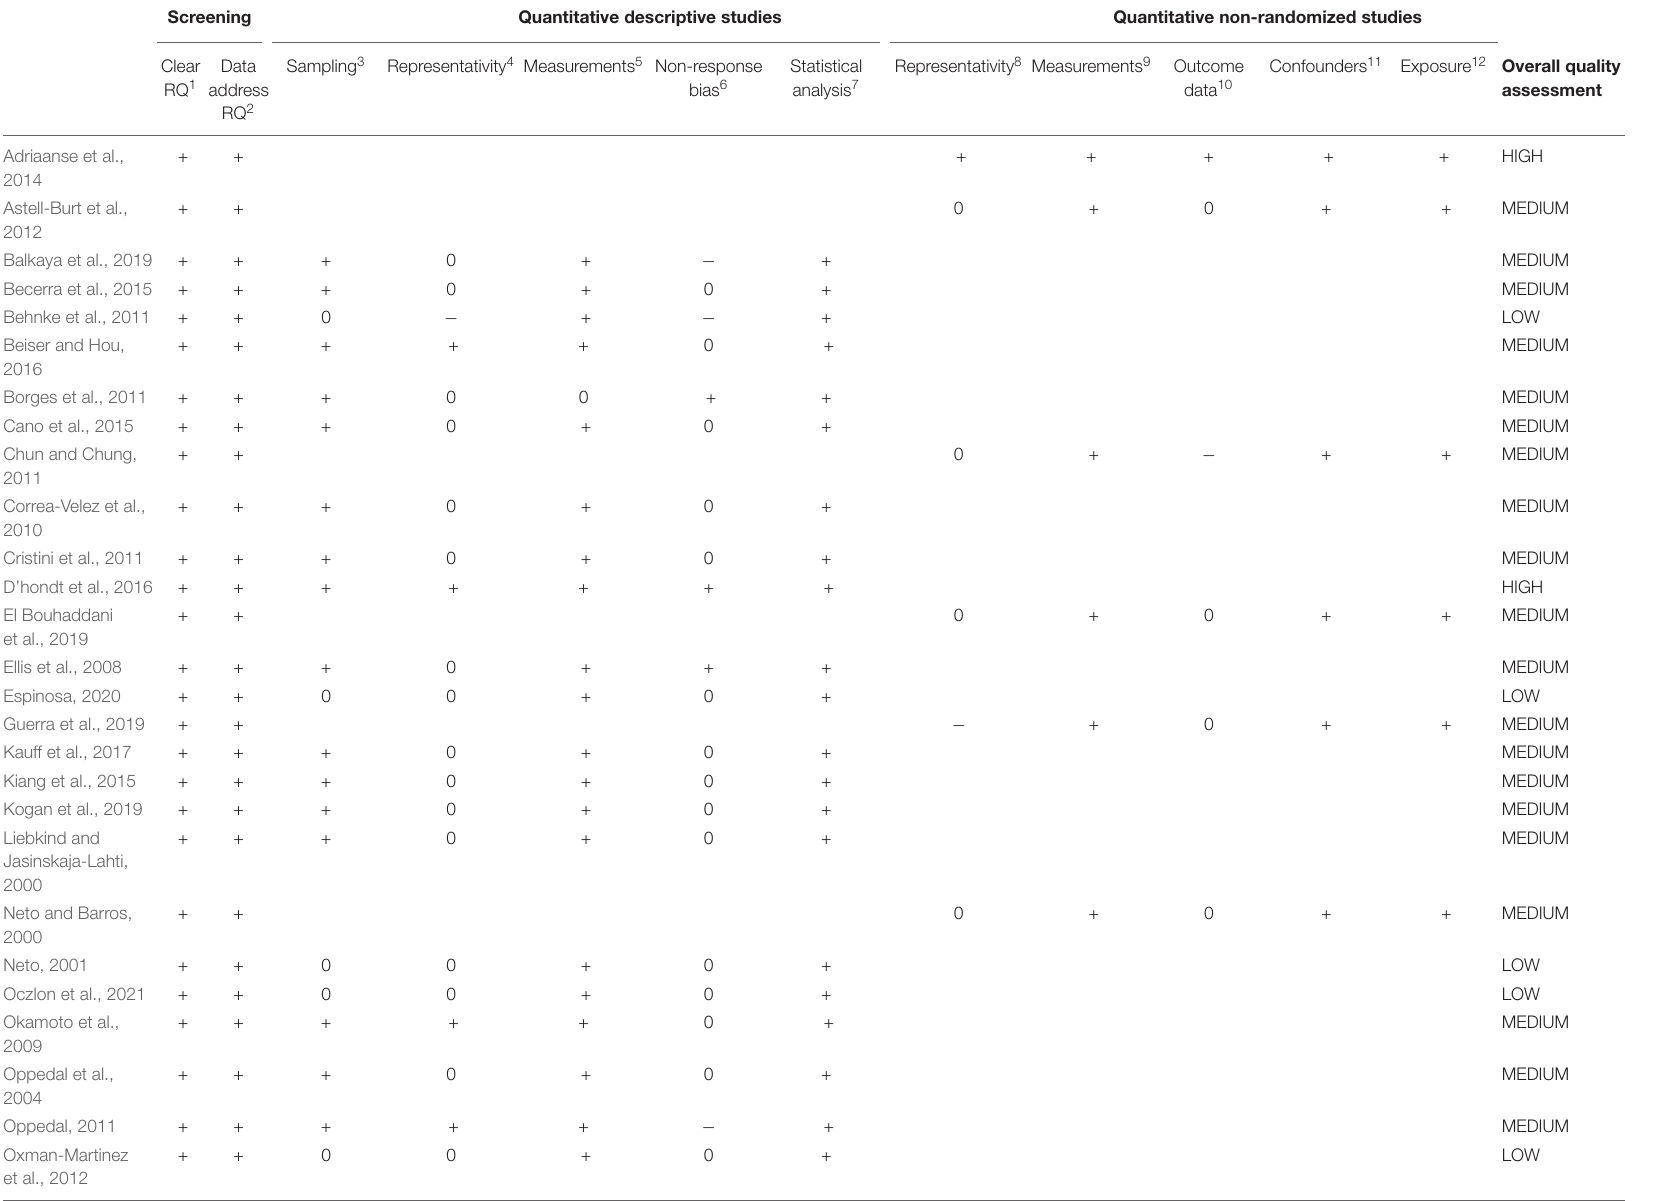
TABLE 3 | Adapted rating of the methodological quality of included studies ( k = 34) based on the Mixed Methods Appraisal Tool (MMAT; Hong et al.,